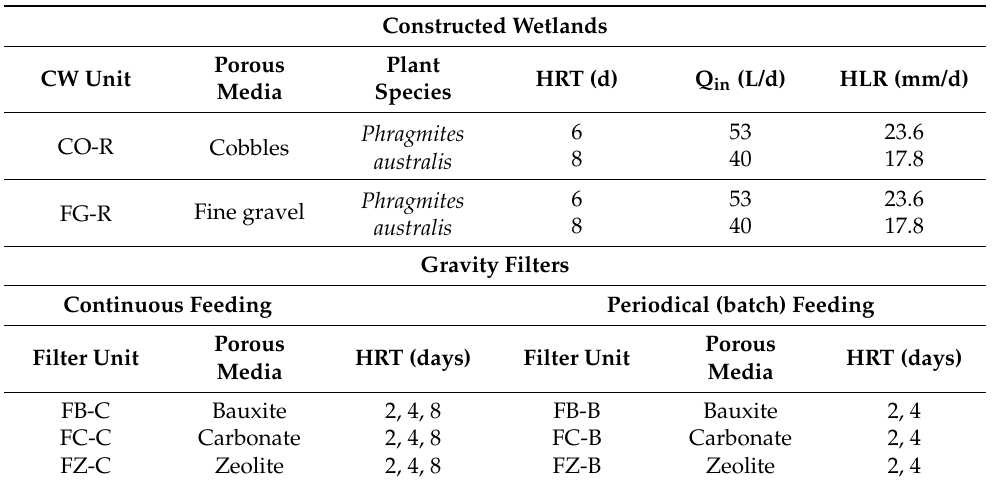
Table 2. Design and operational characteristic of HSF-CWs and gravity filter units. Constructed